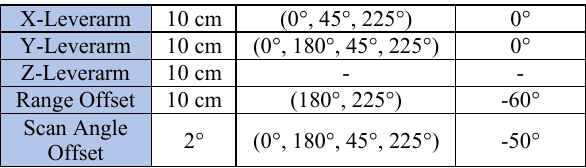
Table 2 – Best configurations for all systematic errors